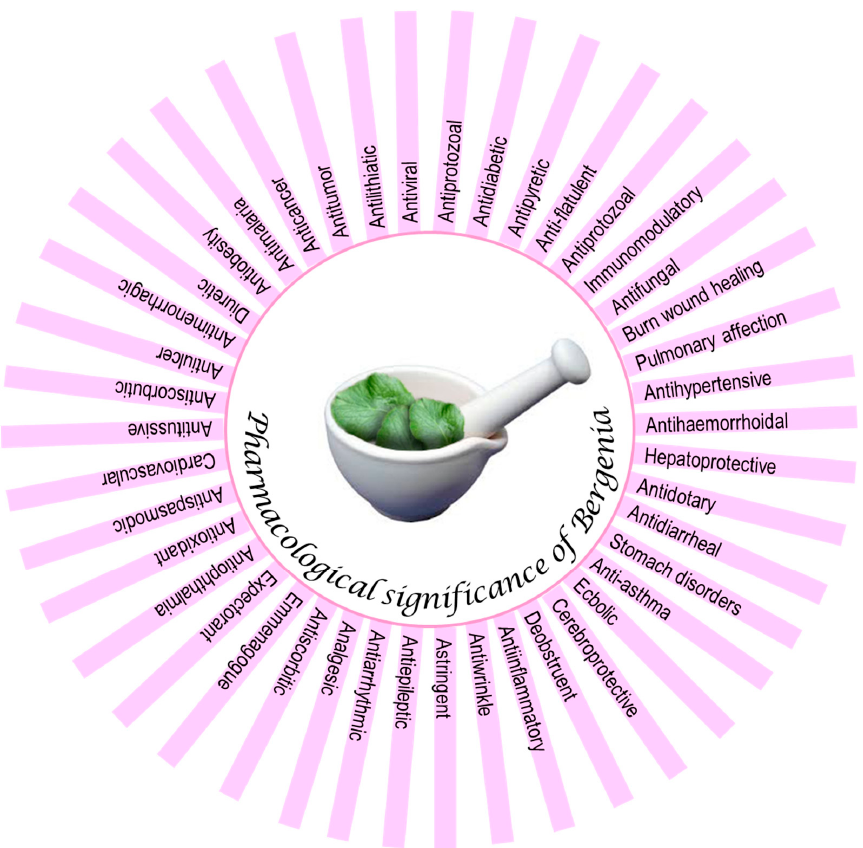
Figure 2. Pharmacological significance of Bergenia species.